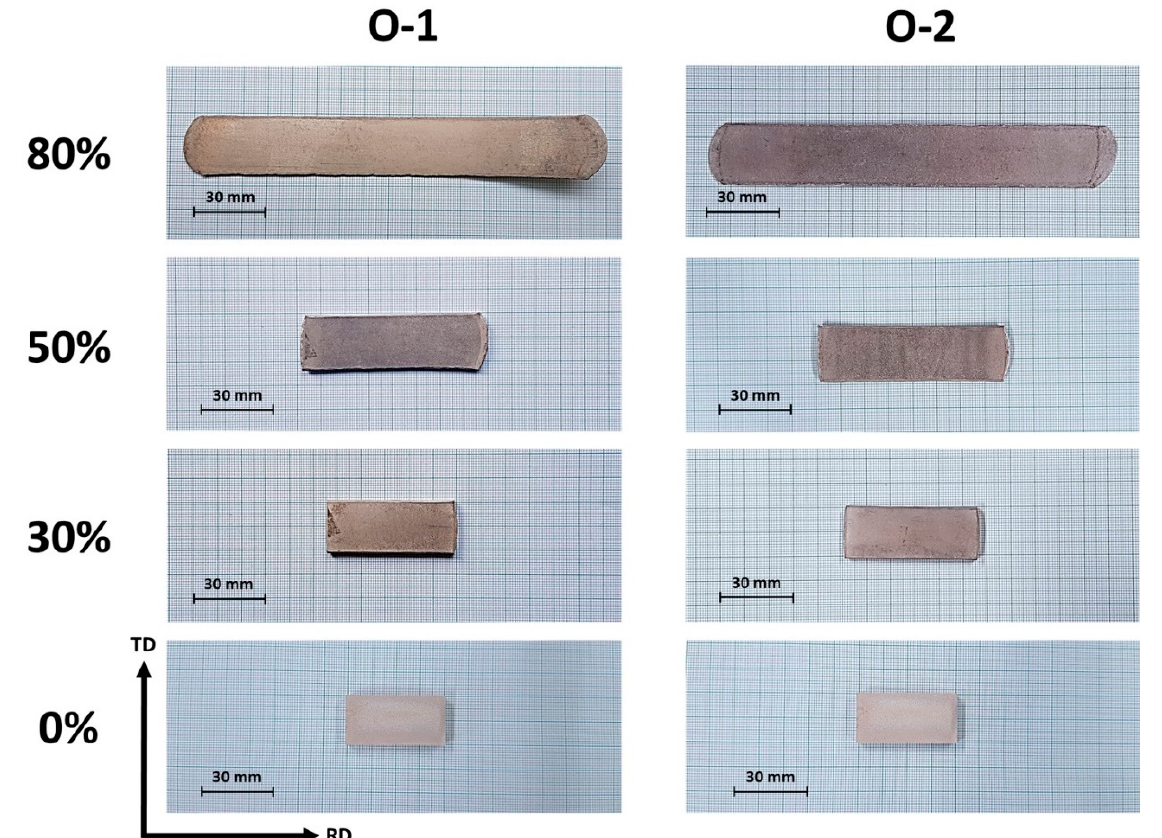
Figure 2. Pictures of magnesium hot-rolled sheets of orientation 1 and orientation 2 at 0% (raw material) 30%, 50% and 80% of thickness reduction.